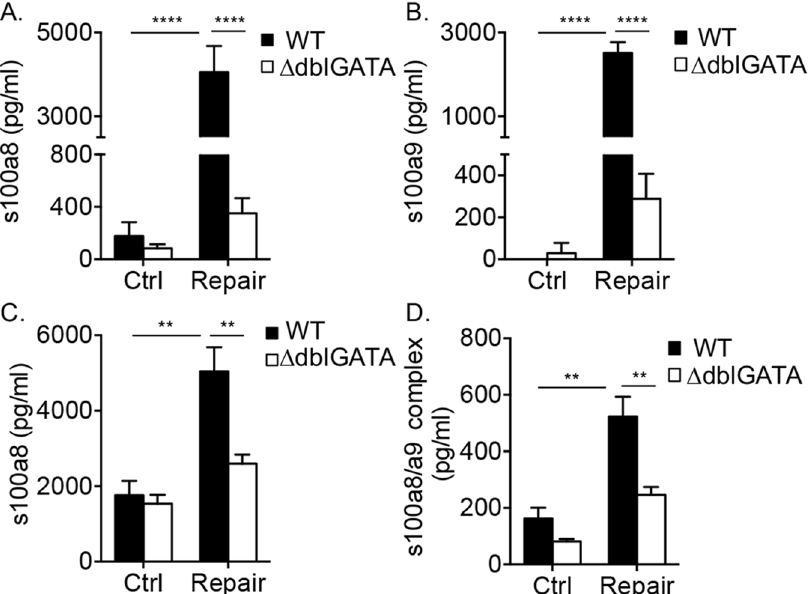
Figure 5. Induction of s100a8 and s100a9 is impaired in eosinophil deficient mice. The expression of monomeric s100a8 and s100a9 ( A–C ) and heterodimeric ( D ) protein forms were determined in the supernatants of colonic punch biopsies ( A,B ) and in the serum ( C,D ) obtained from control (Ctrl) mice, and mice during the inflammatory (DSS) and tissue repair stage. Data are from at least n = 3 experiments, ** p < 0.01; **** p <